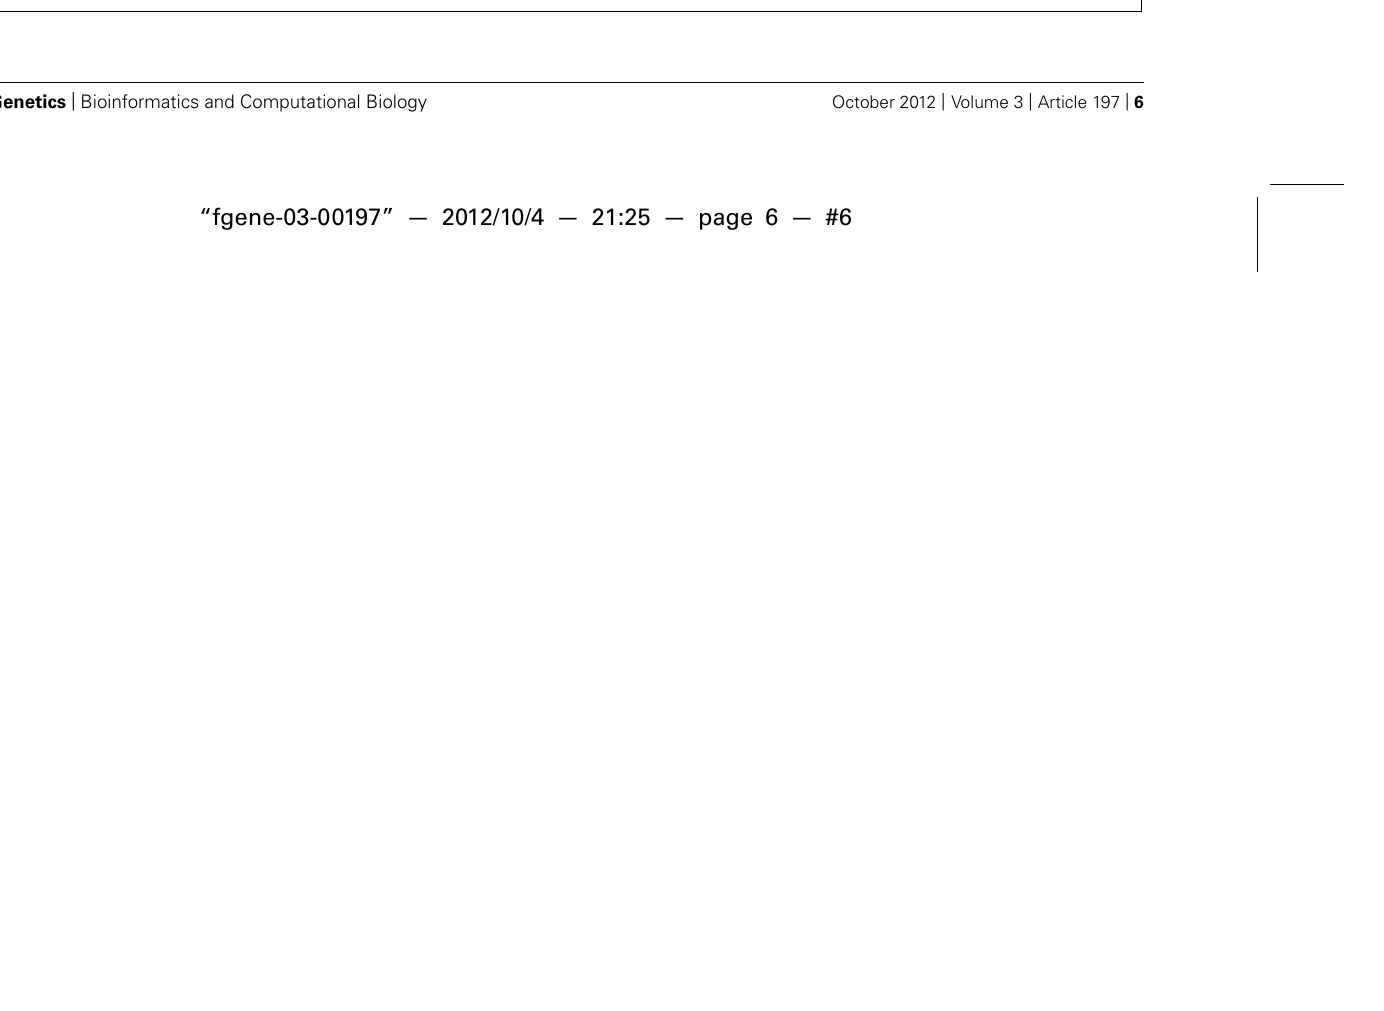
Frontiers in Genetics | Bioinformatics and Computational